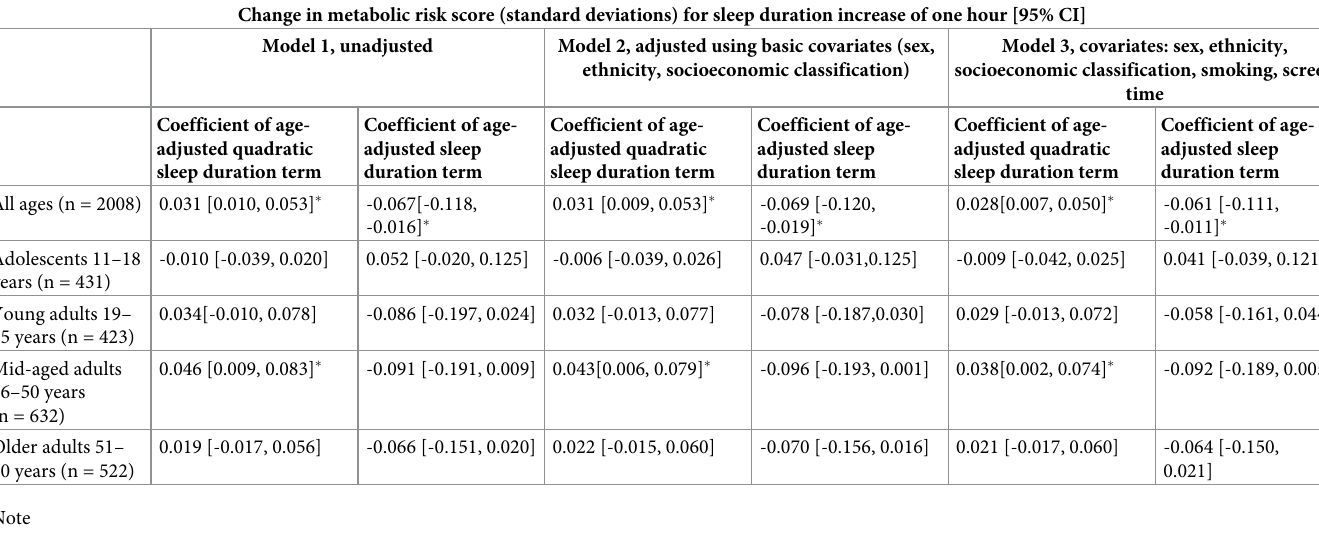
Table 2. Cross-sectional associations between sleep duration and metabolic risk score, presenting coefficients for both the quadratic sleep duration term and the linear sleep duration term from the regression model. Change in metabolic risk score (standard deviations) for sleep duration increase of one hour [95% CI] Model 1, unadjusted Model 2, adjusted using basic covariates (sex, Model 3, covariates: sex, ethnicity, ethnicity, socioeconomic classification) socioeconomic classification, smoking, screen